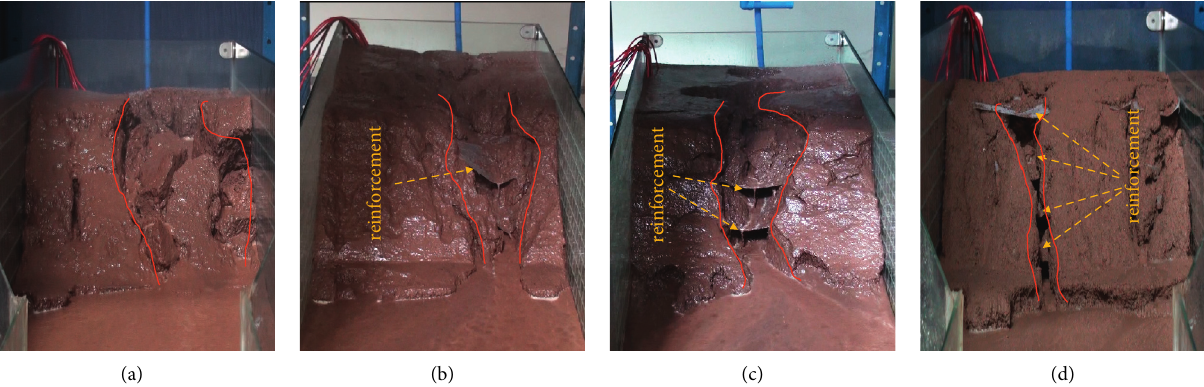
Figure 9: Erosion failure phenomena of different reinforcement layers: (a) N � 0; (b) N � 1; (c) N � 2; (d) N �